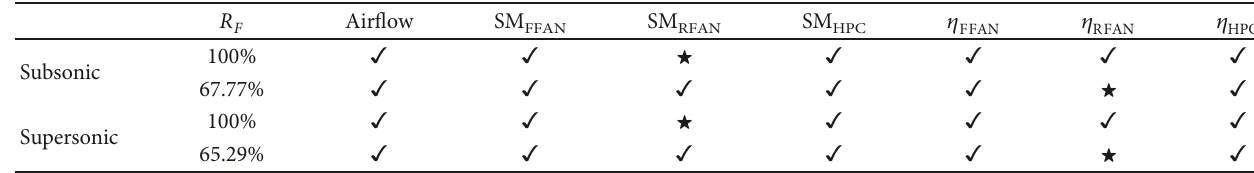
Table 7: Important parameter during throttling (group 2).